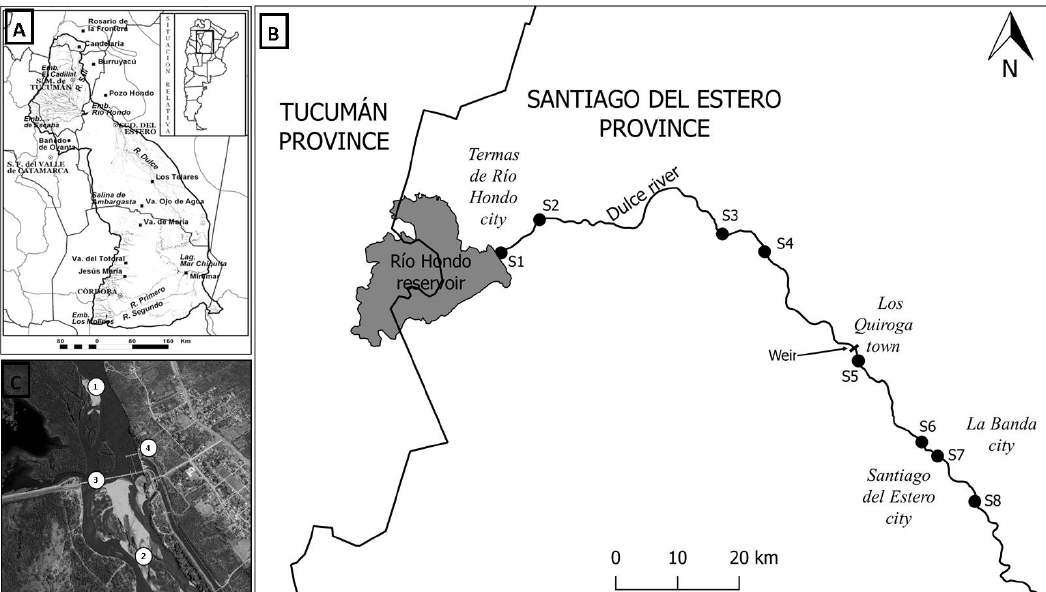
Figure 1. Study area. (A) Salí-Dulce basin map (Source: Salí-Dulce Basin Committee); (B) Location of sampling sites (S1-S8); (C) Weir location detail, satellite photography (August 2014, Google Earth). (1) upstream reach; (2) downstream reach; (3) bridge over the weir; (4) irrigation system matrix